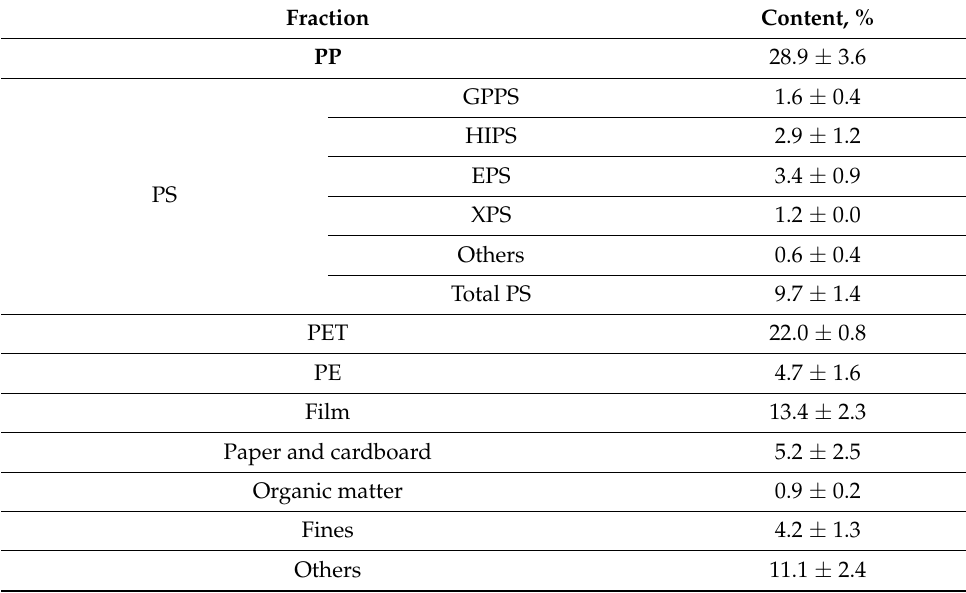
Table 1. Results of the identification of the polymers presented in the bales of non-recyclable mixed plastics from municipal solid